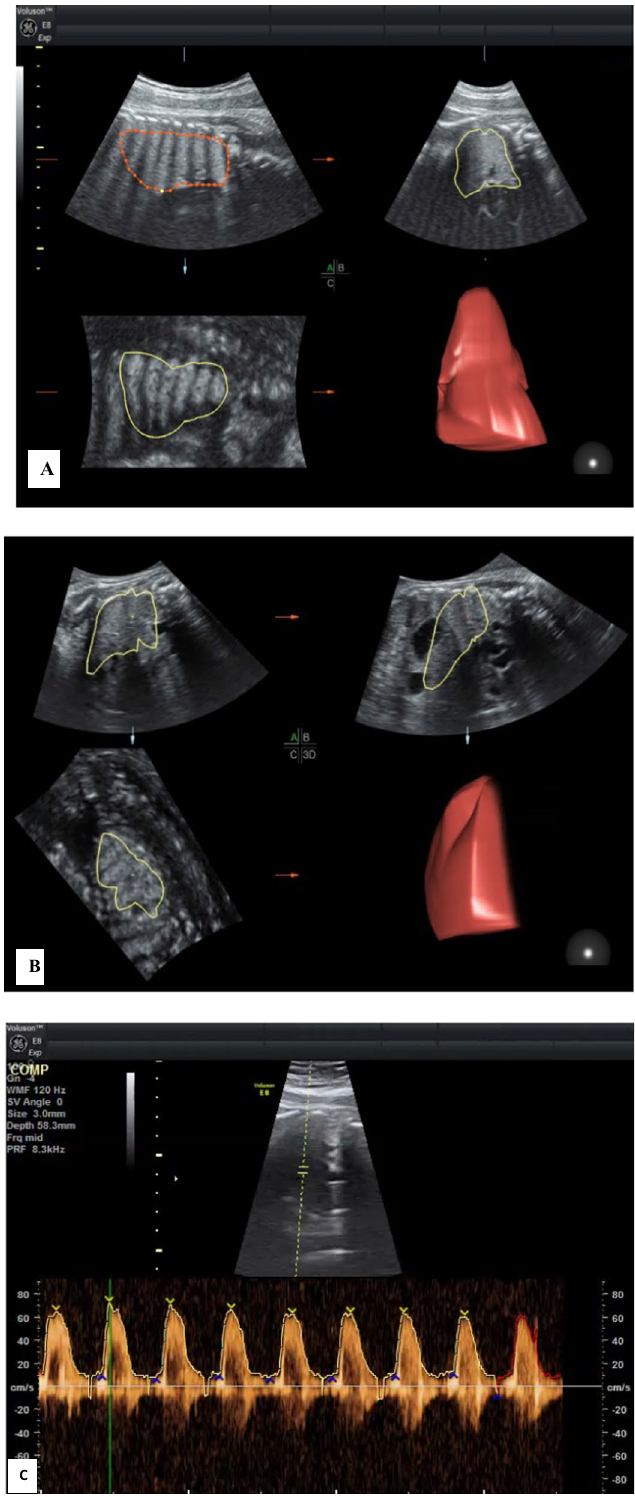
Fig. 2 A – C Lung volume of pregnant patient 23 years old, GA of right lung ( A ) and left lung ( B ) 31 cm 3 and 29 cm 3 , respectively. C The pulmonary artery resistance index (RI) of the same patient measured by pulsed Doppler RI 0.74. (Neonate with mild RD admitted to ICU for 2 =